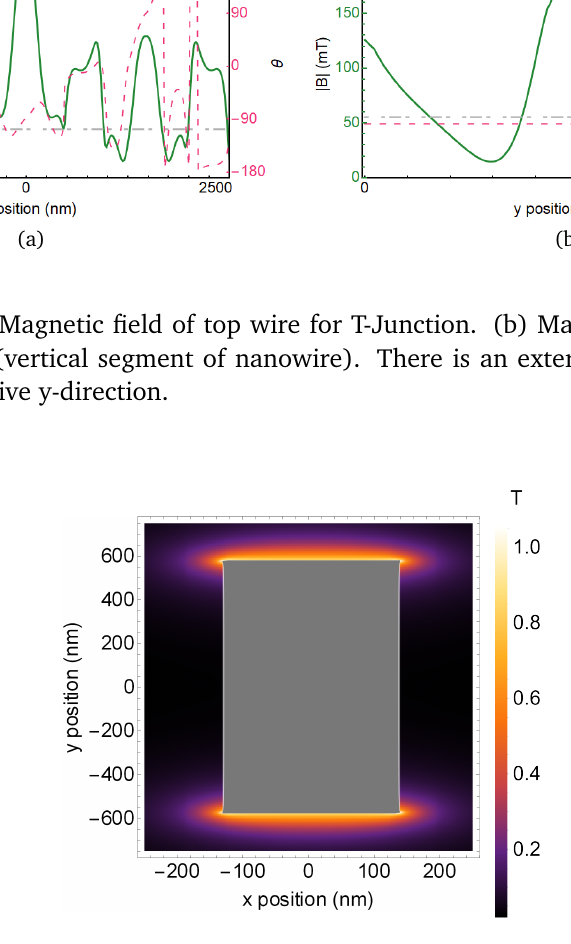
Figure 15: A heat map for magnetic field magnitude for a micromagnet of dimensions 230X1000X100 nm. This is shown for a 2D X-Y plane slice through the middle of the micromagnet (50nm), the magnet is shown as grey. Note the field is very weak away from the micromagnet